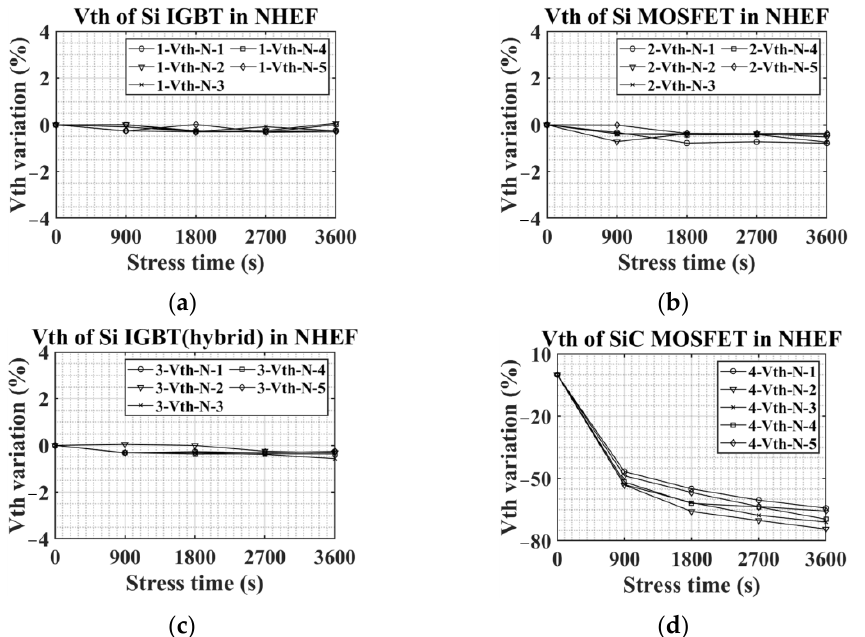
Figure 8. V th variations in NHEF stress: ( a ) Si IGBT, ( b ) Si MOSFET, ( c ) Si IGBT with SiC diode, and ( d ) SiC MOSFET.